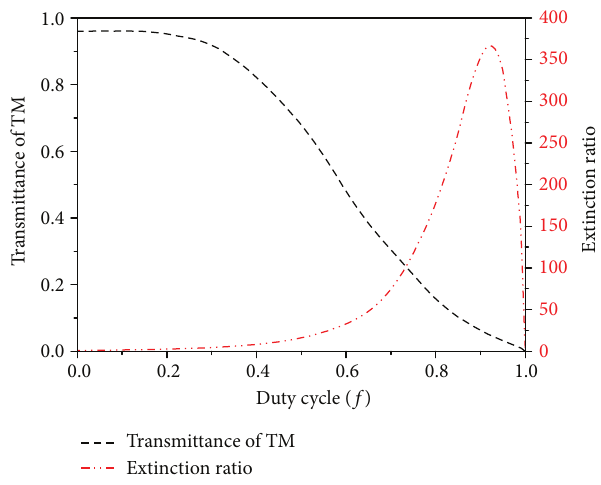
Figure 2: Calculated relationship between the duty cycle and the transmittance of TM and extinction